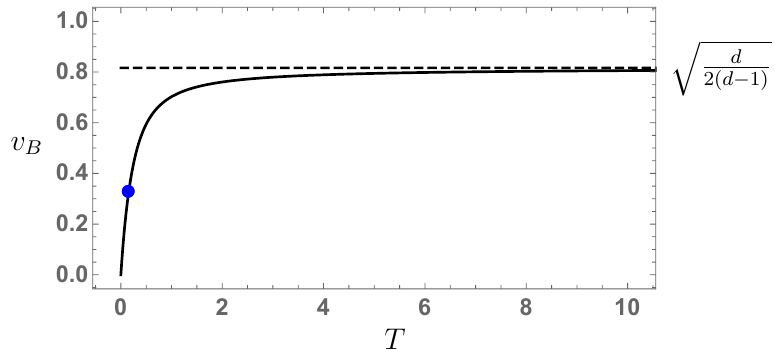
Figure 3 . Temperature dependence of the butter(cid:13)y velocity for hyperbolic black holes. The Rindler-AdS d +1 result ( T; v B ) = ( 1 and ‘ =